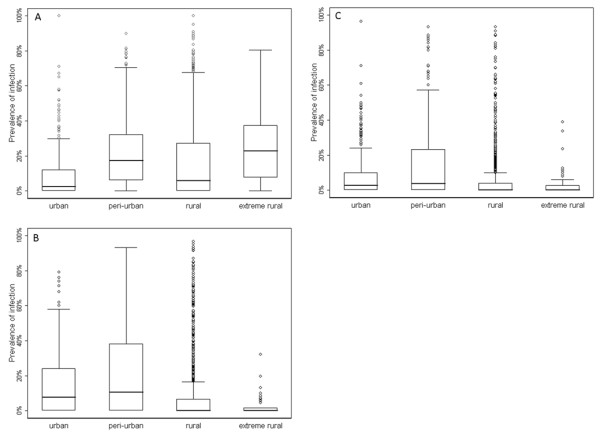
Boxplots showing the distribution of helminth survey data by population density classification, for (A) hookworm, (B)A. lumbricoidesand (C)T. trichiura. Urban areas are defined using Urban Extents (UE) from the Global Urban Rural Mapping Project (GRUMP); peri-urban defined as <15 km from the UE edge and having population densities >250/km2, rural as >15 km from the UE edge and/or population density <250/km2 and extreme rural population density <1/km2 using an updated Gridded Population of the World (GPW3) population database. The thick black line indicates the median, the box, the 25th and 75th percentile, whiskers indicate the range of the data and dots extreme outliers.